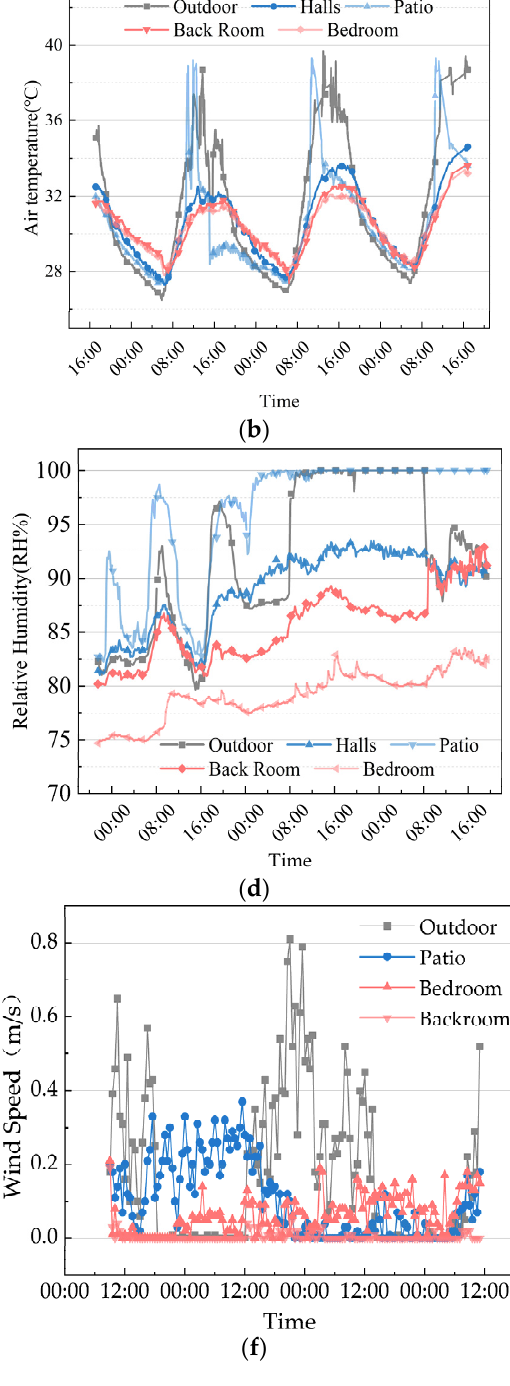
Figure 10. Indoor thermal environment monitoring results of the “Yao’s House”. ( a ) Indoor air temperature distribution in winter; ( b ) indoor air temperature distribution in summer; ( c ) indoor relative humidity distribution in winter; ( d ) indoor relative humidity distribution in summer; ( e ) indoor air velocity distribution in winter; and ( f ) indoor air velocity distribution in summer.